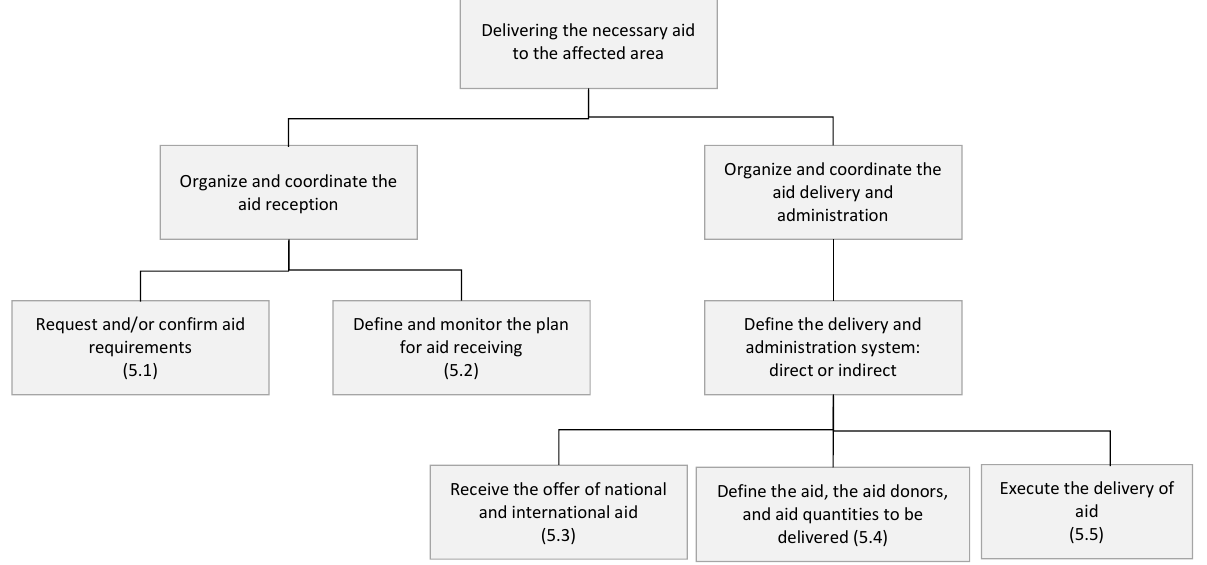
Fig. 5. WBS of Colombian Aid Management subproject